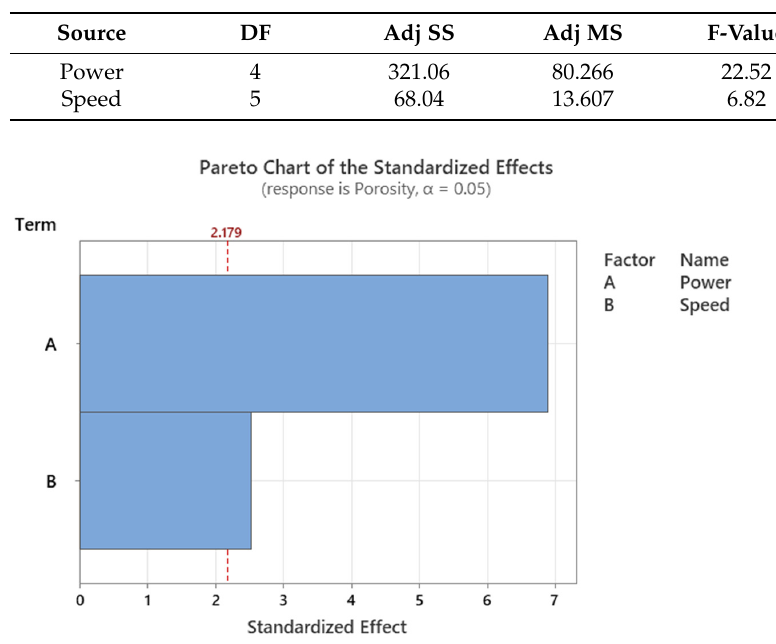
Figure 7. Pareto chart of the standardized effect of laser power and scan speed on porosity .